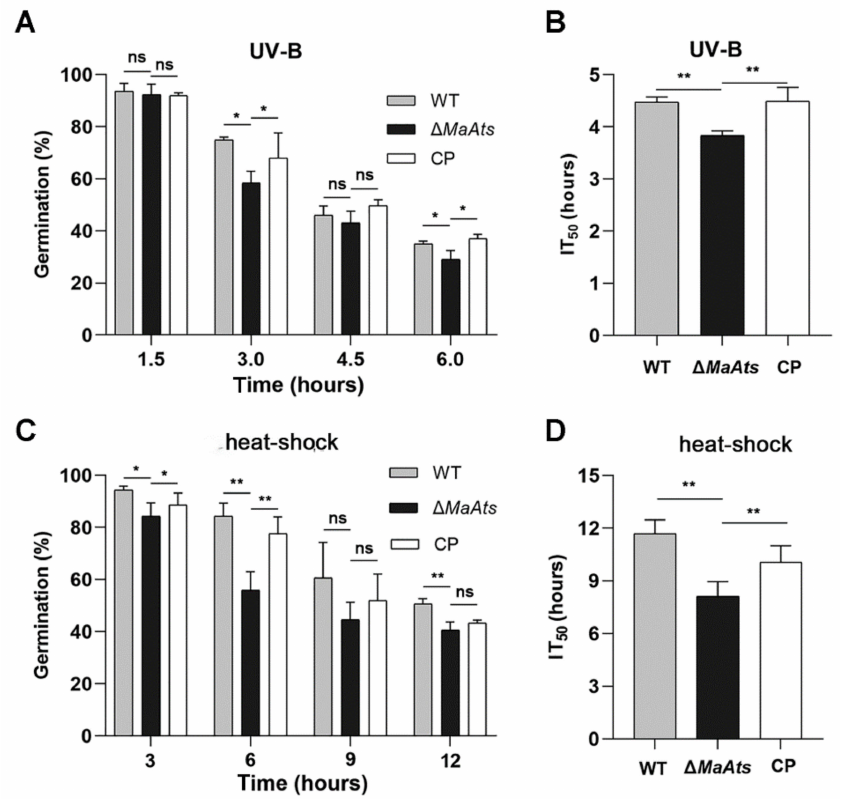
Figure 4. The deletion of MaAts impaired the UV-B irradiation and heat-shock tolerances of the mature (15-day-old) conidia. ( A ) Conidial germination after exposure of UV-B irradiation (1350 mW/m 2 ) in a 1.5 h interval. ( B ) The half-inhibition time (IT 50 ) under UV-B irradiation. ( C ) Germination rates after heat-shock treatment (45 ◦ C) in a 3 h interval. ( D ) IT 50 under high temperature (45 ◦ C). After treatments, WT, ∆ MaAts and CP strains were cultured on nutrient-rich 1/4 SDAY medium at 28 ◦ C for 20 h. Asterisk indicates significant difference at (**) p < 0.01, (*) p < 0.05, (ns) p >